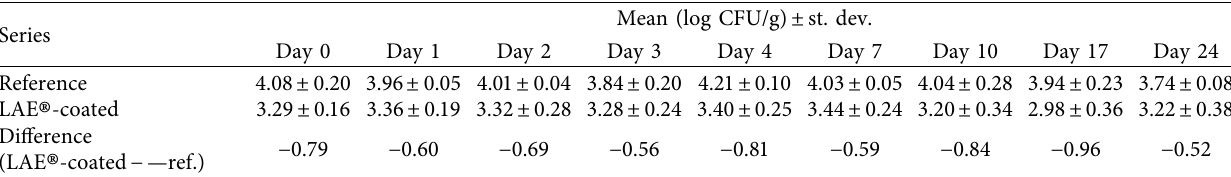
Mean (log CFU/g) ± st. dev.